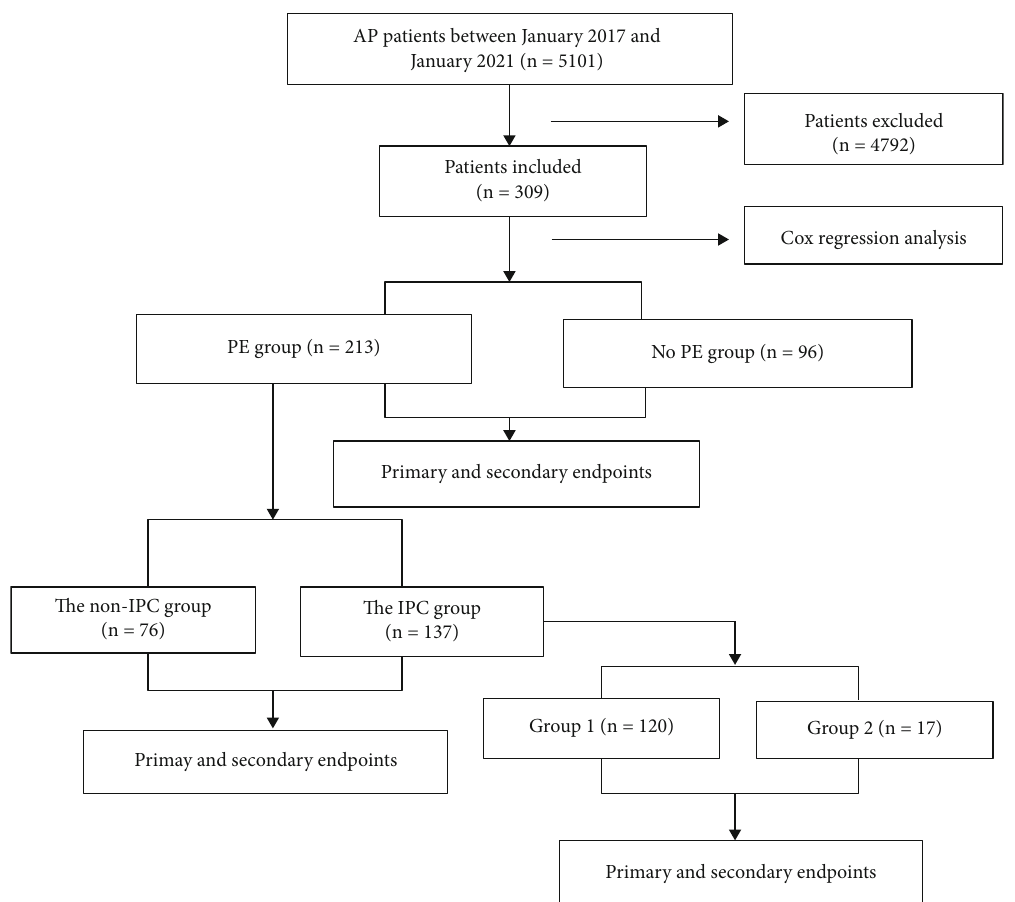
Figure 1: Flowchart of study. PE: pleural e ff usion; IPC: indwelling pleural catheter. Group 1: IPC within 1 week of onset. Group 2: IPC after1 week of